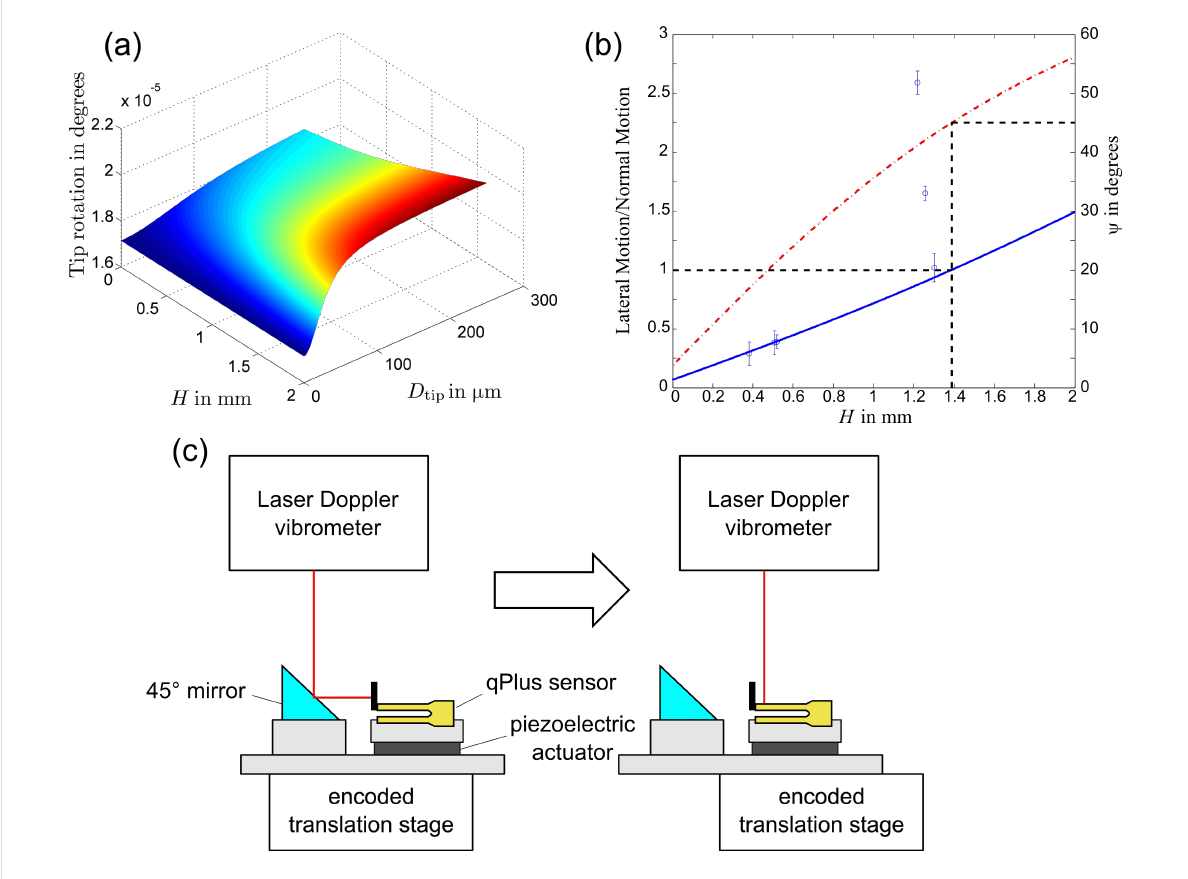
Figure 3: Effect of tip geometry on tip movement for an arbitrary oscillation amplitude. (a) Angle of tip rotation plotted for varying tip sizes. (b) Ampli- tude of lateral motion of the tip apex plotted (solid line) for varying lengths with a tip diameter of 50 μ m. Circular data points represent experimentally measured values. Angle of resulting motion, ψ of the tip apex is also plotted (dot-dashed line). The dashed lines represent where the lateral ampli- tude equals the normal amplitude. Error bars represent 1 standard error. (c) Schematic of the experimental setup for measuring both normal and lateral motion of the qPlus